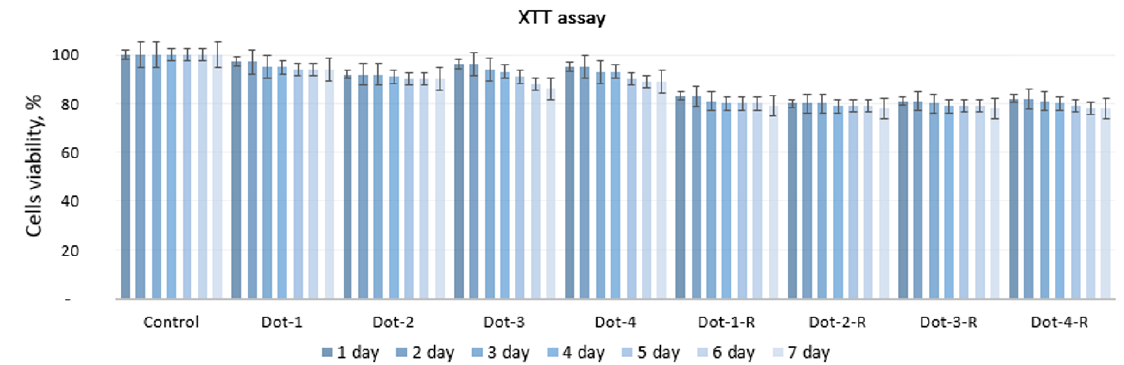
Figure 9. Results of cytotoxicity study (XTT assay) .